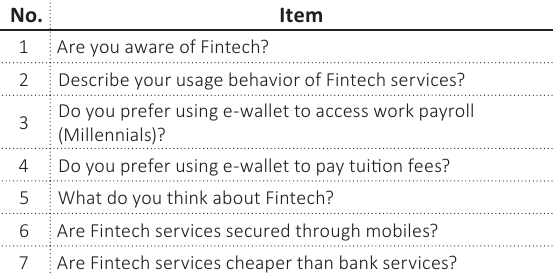
Table 2. Respondent’s Fintech perception